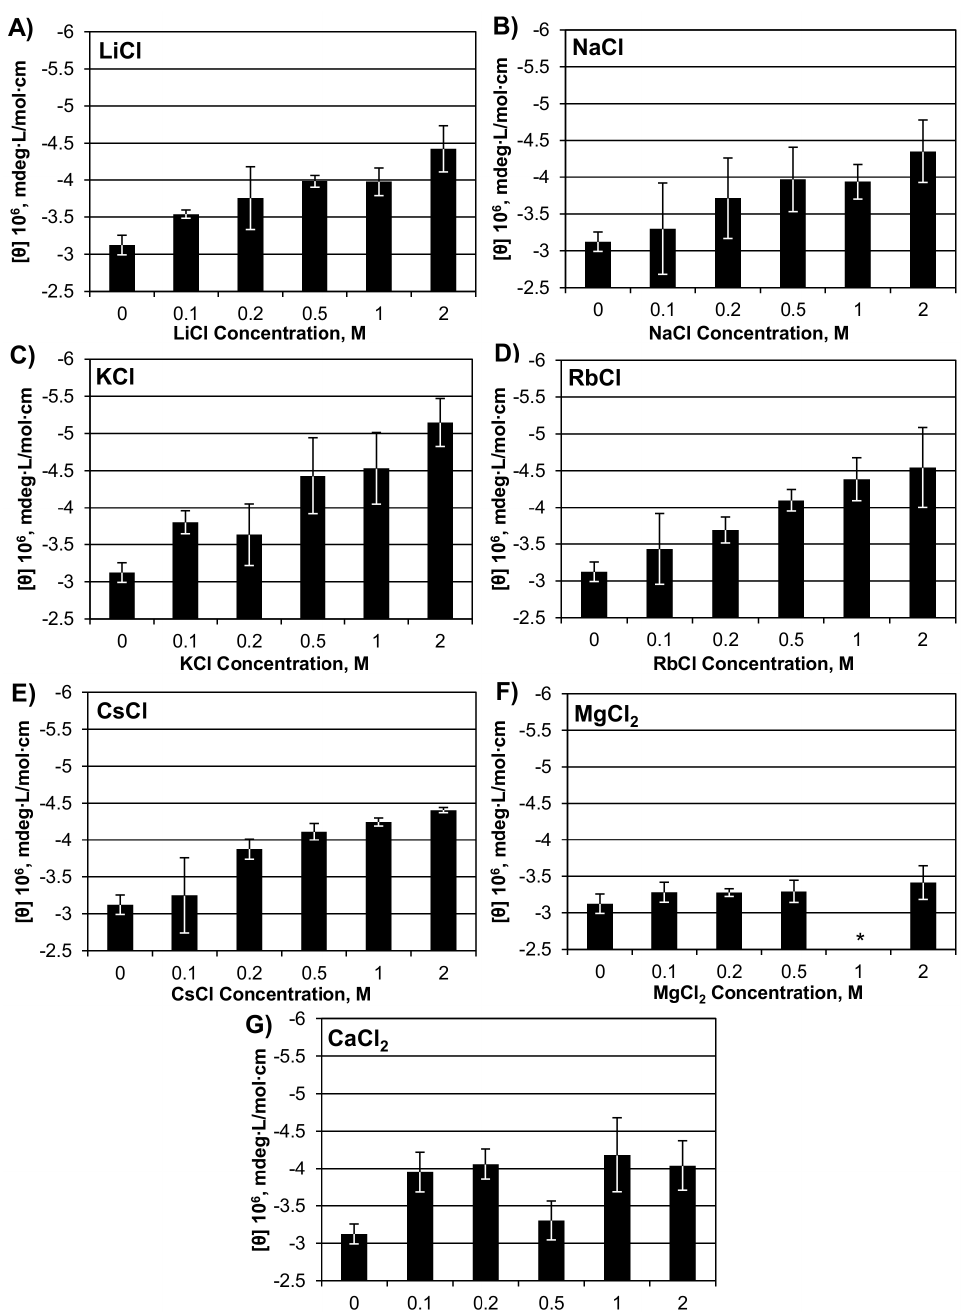
Figure 1. Changes in the ellipticity of NRC-1 CysRS caused by various salts. The circular dichroism signal of NRC-1 CysRS was measured at 222 nm in different concentrations of group I and group II salts: LiCl (A), NaCl (B), KCl (C), RbCl (D), CsCl (E), MgCl 2 (F), and CaCl 2 (G). Three independent spectra were recorded and the standard deviation for each concentration is reported as error bars. * A consistent signal for 1 M MgCl 2 could not be